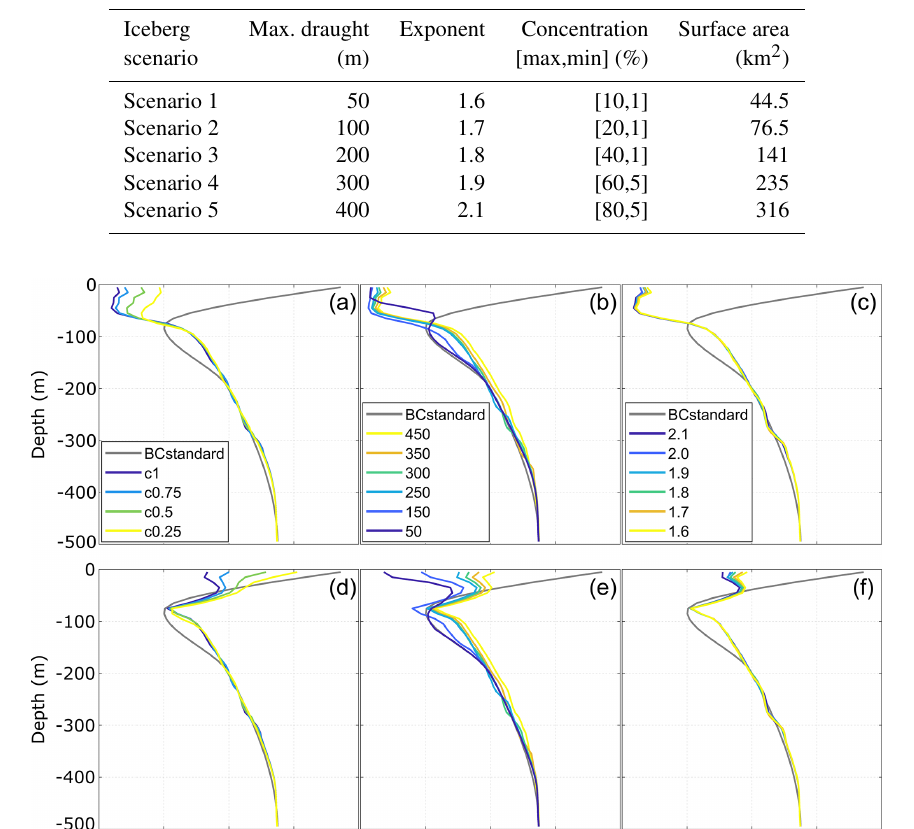
Table 1. Details of each iceberg scenario. Concentration is the percentage of the fjord in plan-view occupied by icebergs. Iceberg concentra- tion was linearly interpolated from the maximum value (adjacent to the glacier wall) to the minimum value 40km down the fjord.